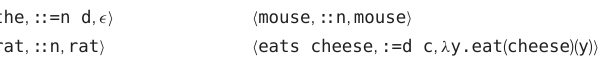
TABLE 8 | Revised minimalist lexicon X 21 .